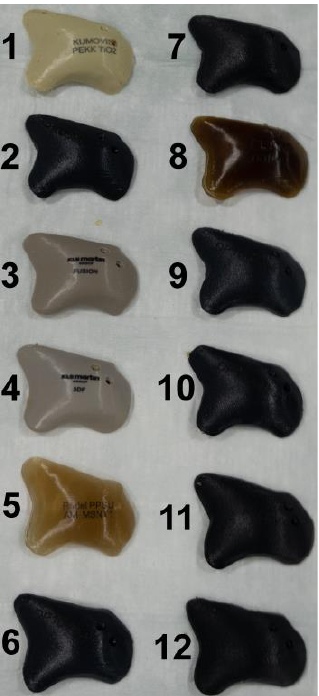
Figure 2. Display of the 12 different zygomatic polymer implants. Numbered: (1) KU PEKK (KUMOVIS GmbH, Munich, Germany); (2) TE PEEK (Ensinger GmbH, Nufringen, Germany); (3) VK iC4800 (EVONIK Industries AG, Essen, Germany); (4) VVK i4 (EVONIK Industries AG, Essen, Germany); (5) Radel PPSU (Solvay GmbH, Hanover, Germany); (6) VK A1 (EVONIK Industries AG,